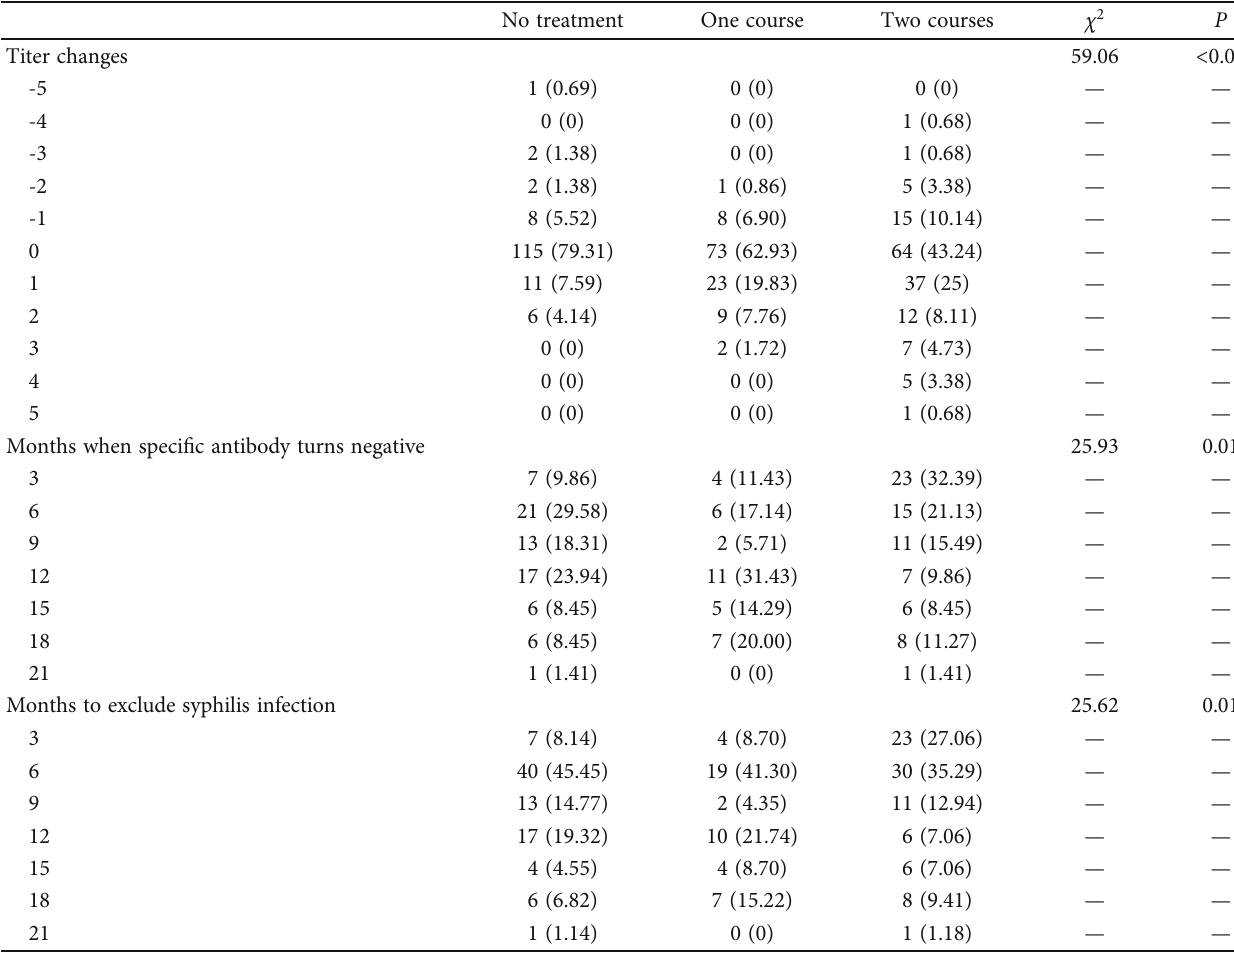
Table 5: Comparison of results features of pregnant women with syphilis with or without treatment during